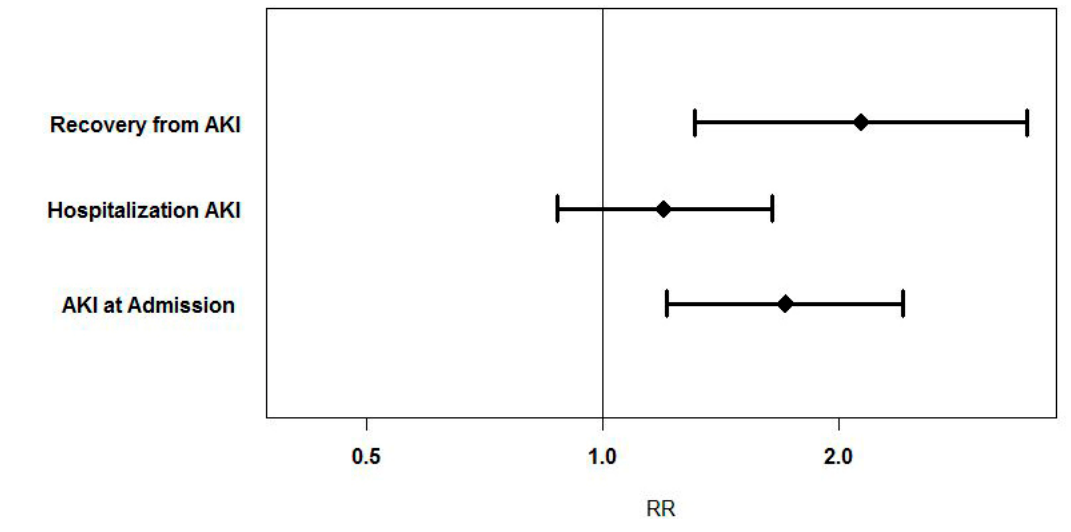
Figure 2. Relative Risk of the various outcomes described, with 95% CIs.